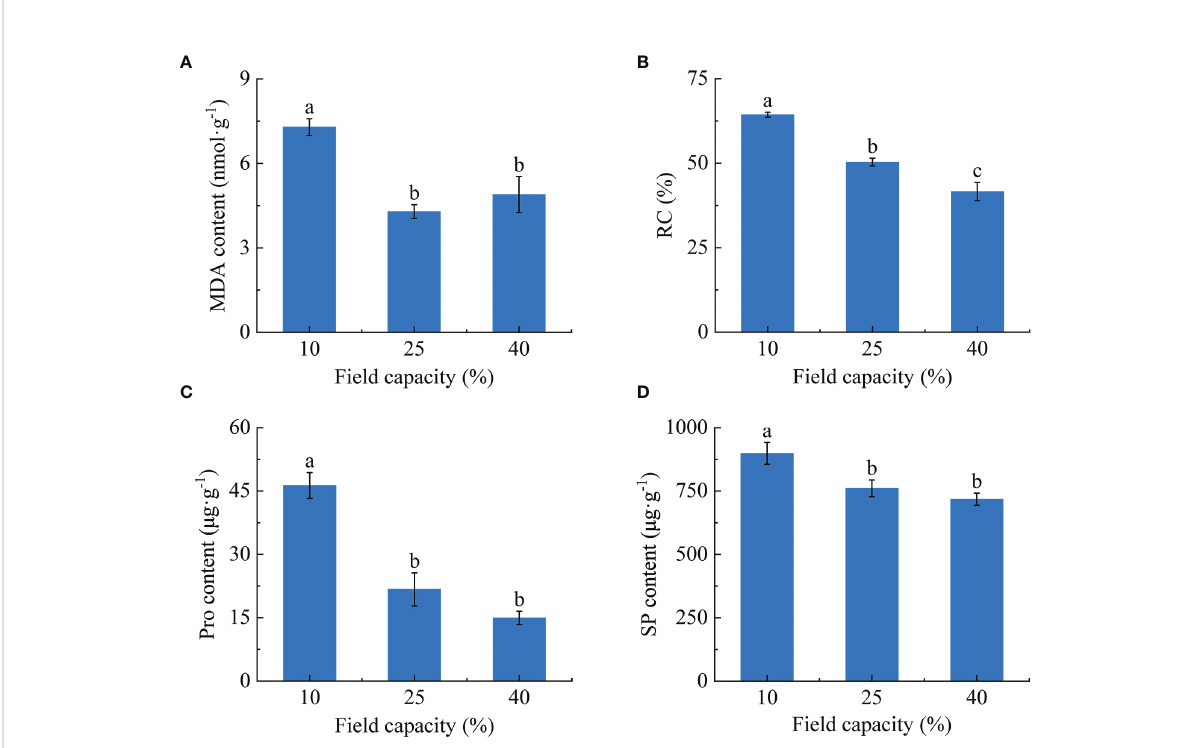
FIGURE 4 Effects of different soil moisture on malondialdehyde (MDA) content (A) , relative conductivity (RC) (B) , proline (Pro) content (C) and soluble protein (SP) content (D) of K hirsuta. Results were analyzed by one-way ANOVA and tested for signi fi cance of difference by Duncan multiple- range method. Each value represents the mean ± standard error. Each experiment was repeated four times. Different letters indicate that the differences between treatments were signi fi cant ( P <